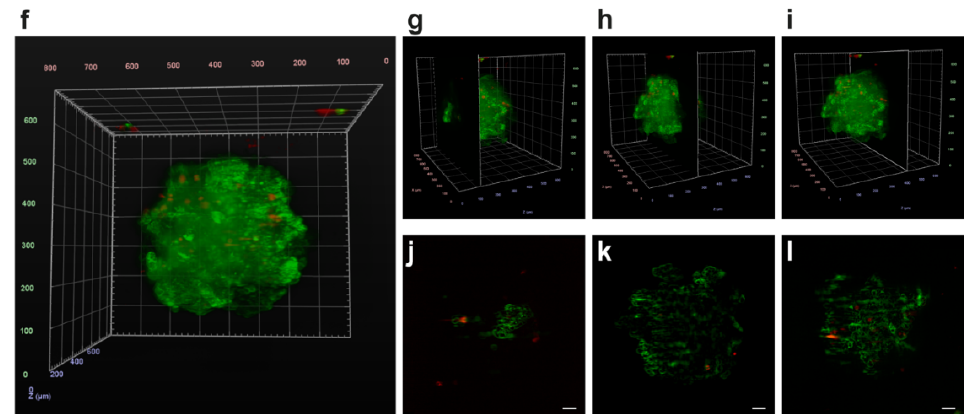
Figure 3. T cell infiltration of GC spheroids. ( a ) Schematic representation of the co-culture timeline. Spheroids (green) resembling intestinal- and diffuse-type GC were independently cultured for 7 days. Thereafter, Tregs and conventional T cells (red) were sorted from peripheral blood of healthy donors, based on the expression of CD3, CD4, IL2R α , and CD127 T cell markers, and added to GC spheroids. After 48 h of co-culture, spheroids were dissociated for further characterization of both T cells and GC cells. ( b – e ) Monitorization of GC spheroids-T cell interactions during the 48 h of co-culture by time-lapse microscopy. Control represents GC spheroids (green) that were not cultured with T cells (red). 1:1, 1:5 and 1:15 (GC cell:T cell) represent the increasing proportions of T cells to GC cells tested for ( b ) intestinal-type spheroids co-cultured with Tregs, ( c ) diffuse-type spheroids co-cultured with Tregs, ( d ) intestinal-type spheroids co-cultured with conventional T cells, ( e ) diffuse-type spheroids co-cultured with conventional T cells. ( f , g ) Light-sheet microscopy of 24 h co-cultures of intestinal- type GC spheroids (green) and Tregs (red). ( f ) Co-culture 3D visualization after four-angle fusion of light-sheet microscopy images. ( j – l ) Lateral views of the 3D representation obtained from the light-sheet imaging data corresponding to the regions indicated in ( g ) ~124 nm, ( h ) ~290 nm,